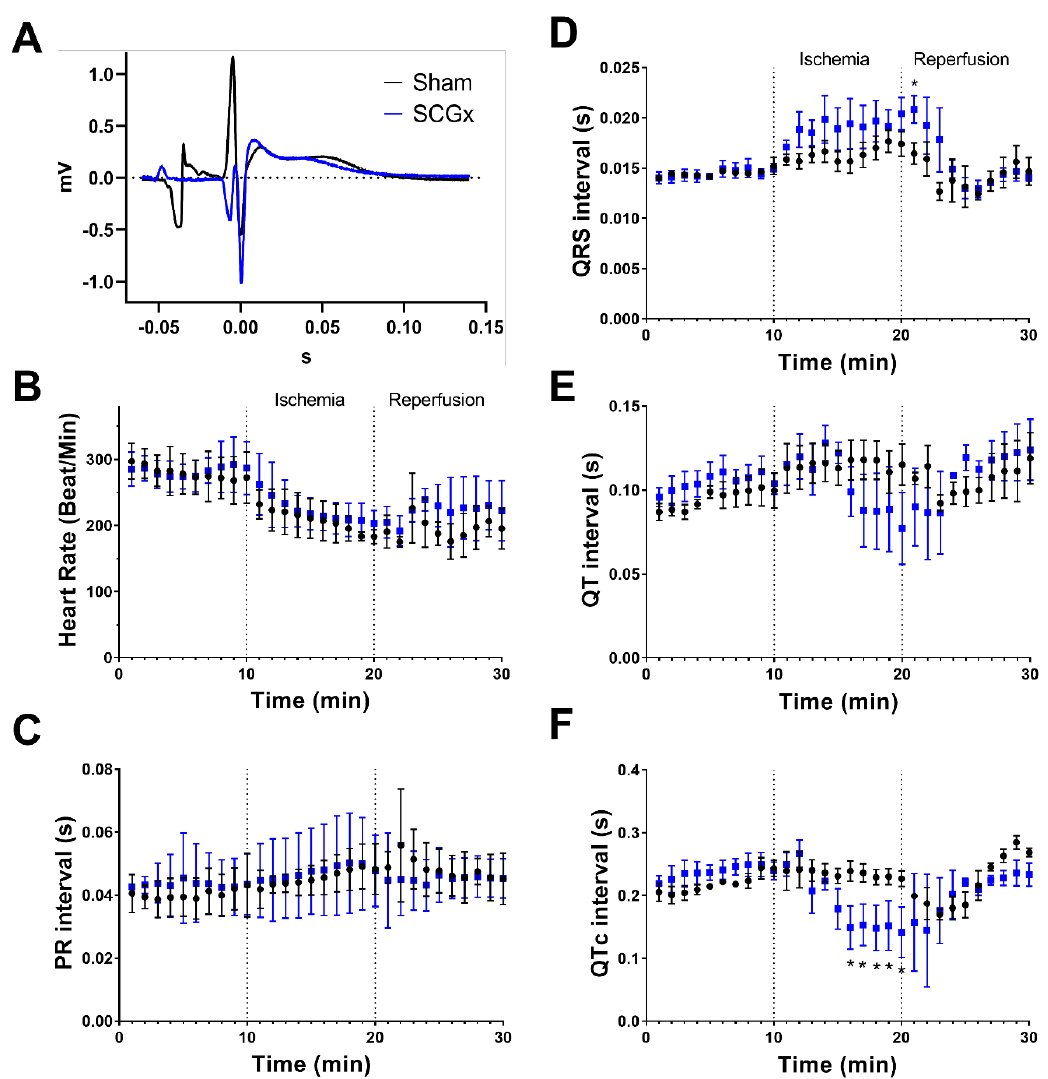
Figure 2. Heart rate and ECG intervals during ischemia / reperfusion. ( A ) Representative ECG from the preischemic period. PR, QRS, or QT intervals did not di ff er between groups. ( B ) Heart rate decreased during ischemia and partially recovered during reperfusion in both groups. ( C ) PR interval showed more dispersion during ischemia in the SCGx group. ( D ) QRS interval increased during ischemia and reached a significant di ff erence at the first minute of reperfusion in the SCGx animals. ( E ) QT interval showed more dispersion during the last minutes of ischemia and the beginning of reperfusion in the SCGx group. ( F ) QTc from SCGx hearts shortened during the last five minutes of ischemia.